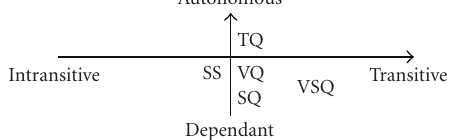
Figure 2: Search session and subsessions.